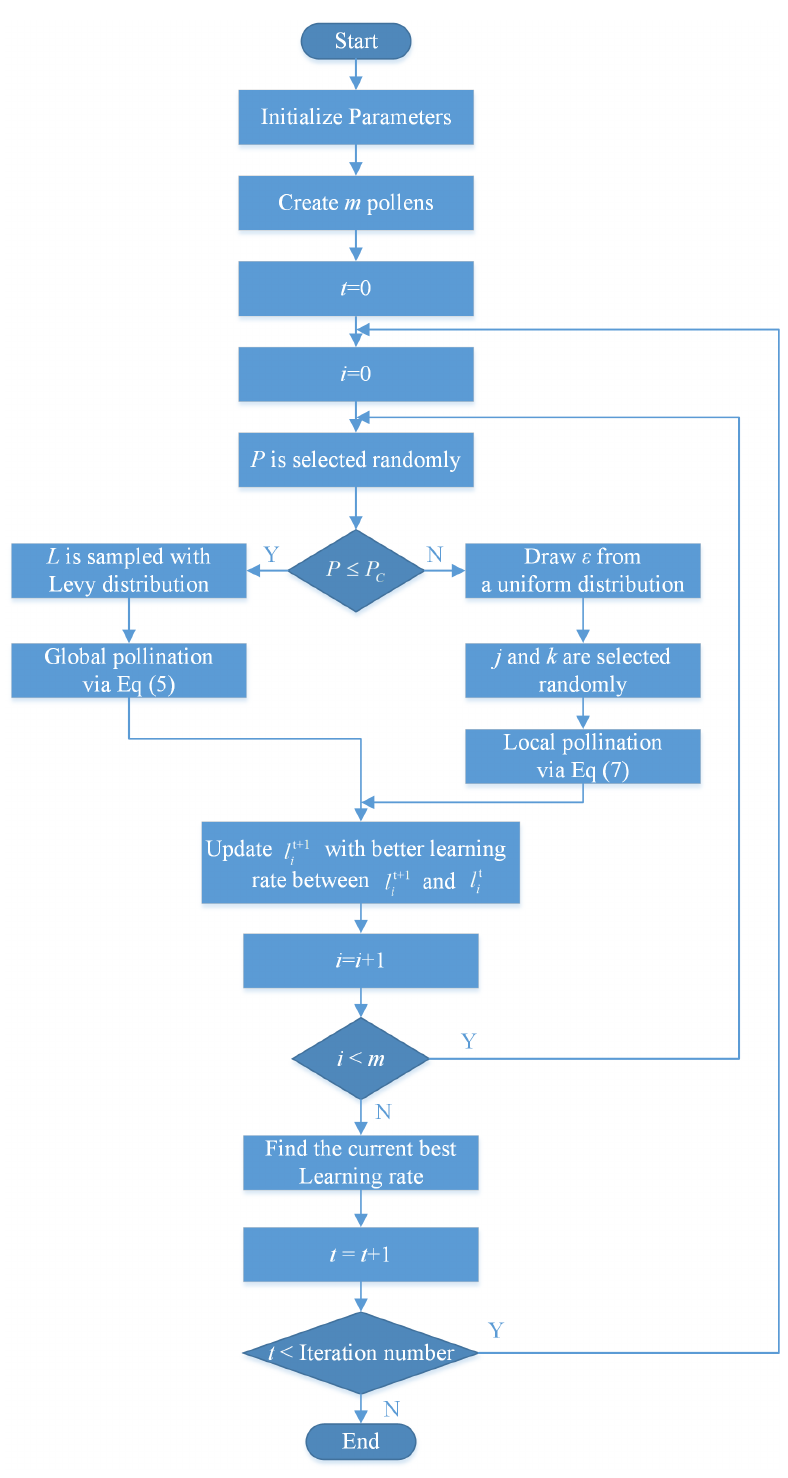
Figure 6. Flow chart of FPA